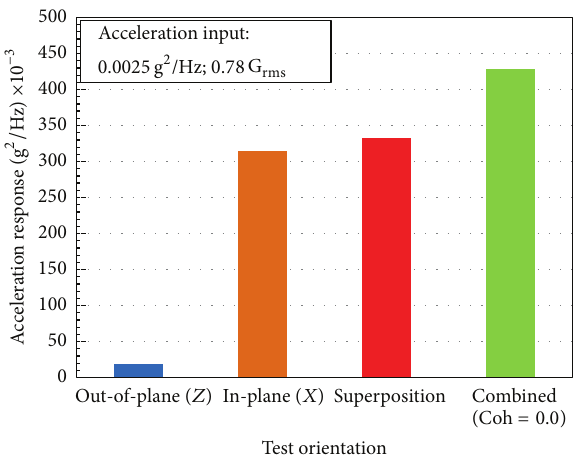
Figure 11: Component 2 acceleration response in the x -direction 0.78 G rms .